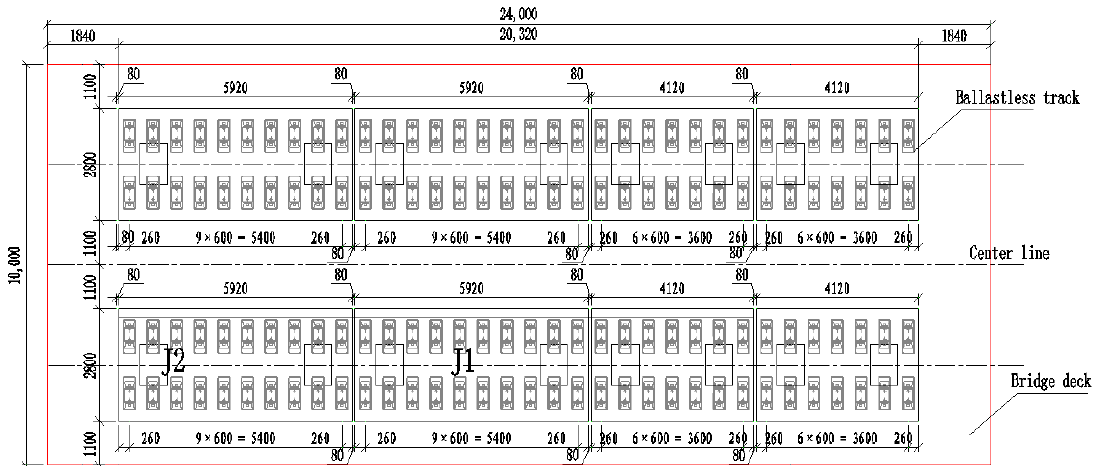
Figure 5. Full-scale ballastless tracks.